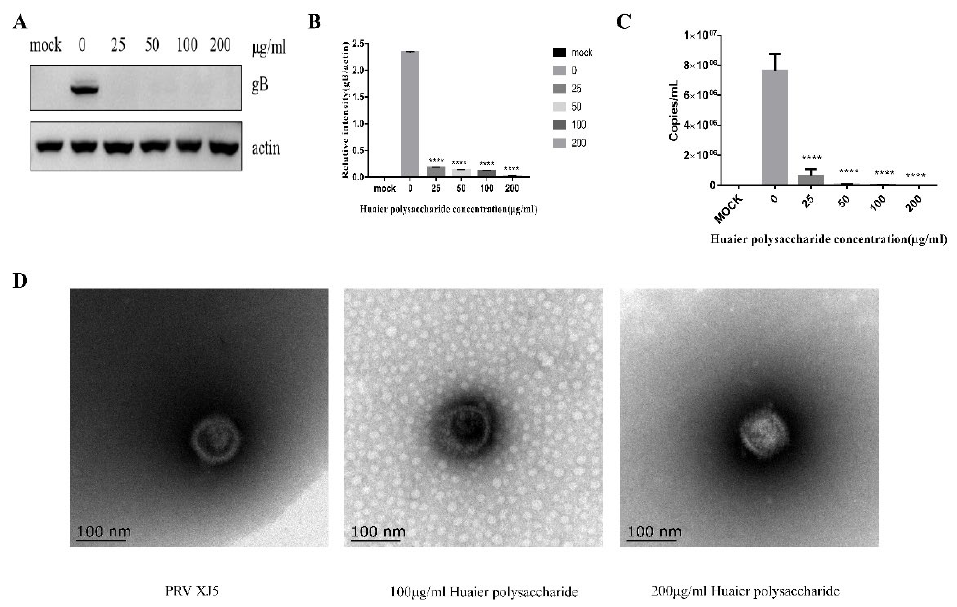
Figure 7. Huaier polysaccharide may directly inactivate PRV XJ5. PRV XJ5 (MOI = 0.1) was treated according to the method described in Section 2.3.8. ( A ) PRV gB was analyzed through Western blotting. ( B ) The relative intensity of intracellular gB to that of actin. ( C ) PRV viral DNA copies were analyzed by qRT-PCR at 24 h.p.i ( D ) PRV particle morphology was observed by electron microscopy. The relative intensities of protein were quantified using Image J. Significance was analyzed using the one-tailed Student’s t -test. **** p < 0.0001. Data are shown as mean ± SD based on three